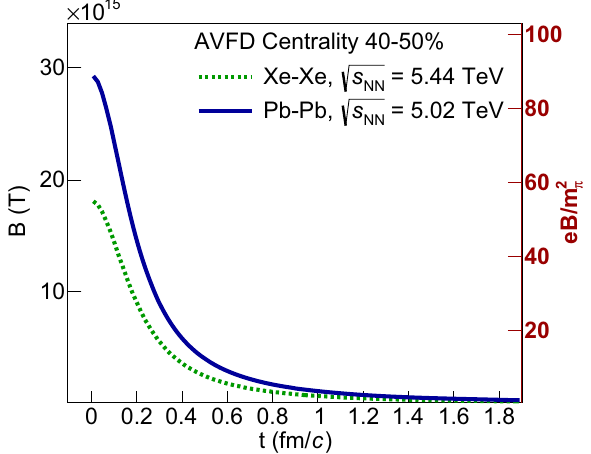
Fig. 2 The time evolution of the average value of the magnetic field perpendicular to the reaction plane ( B ) for the 40–50% centrality inter- val in Pb–Pb and Xe–Xe collisions at 5 . 44 TeV, respectively